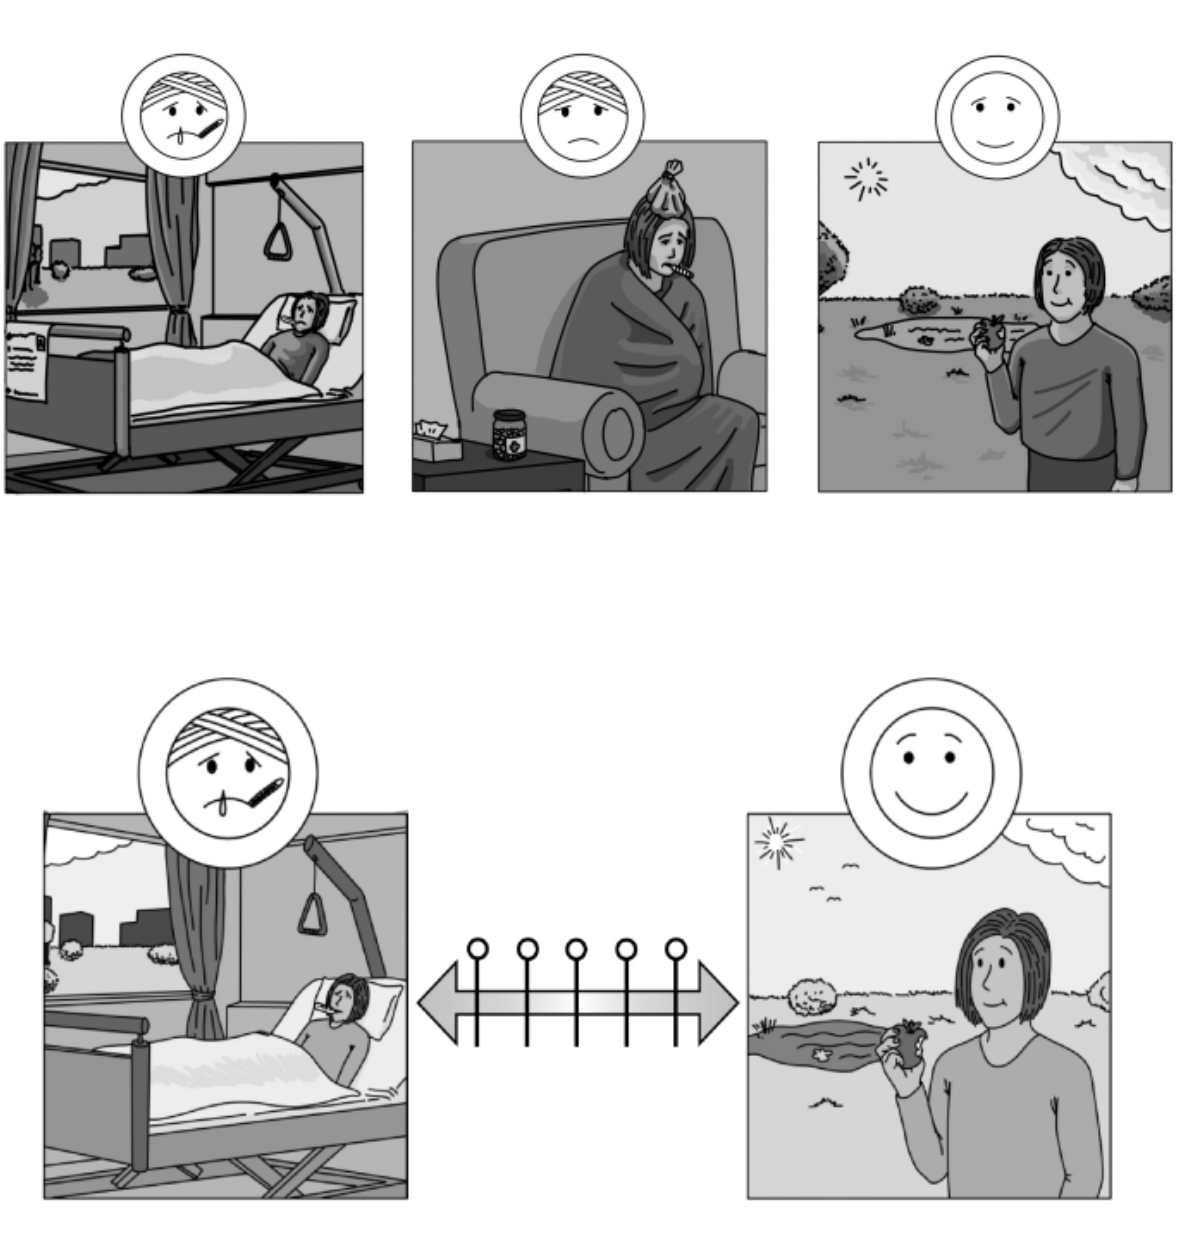
Figure 1. Approaches to the response format of the PictoQOL illustrated using the dimension ‘general health’ as an example (top: original concept visualizing each response category by means of pictures; bottom: final version using a visual 5-point Likert scale response format; Source: own